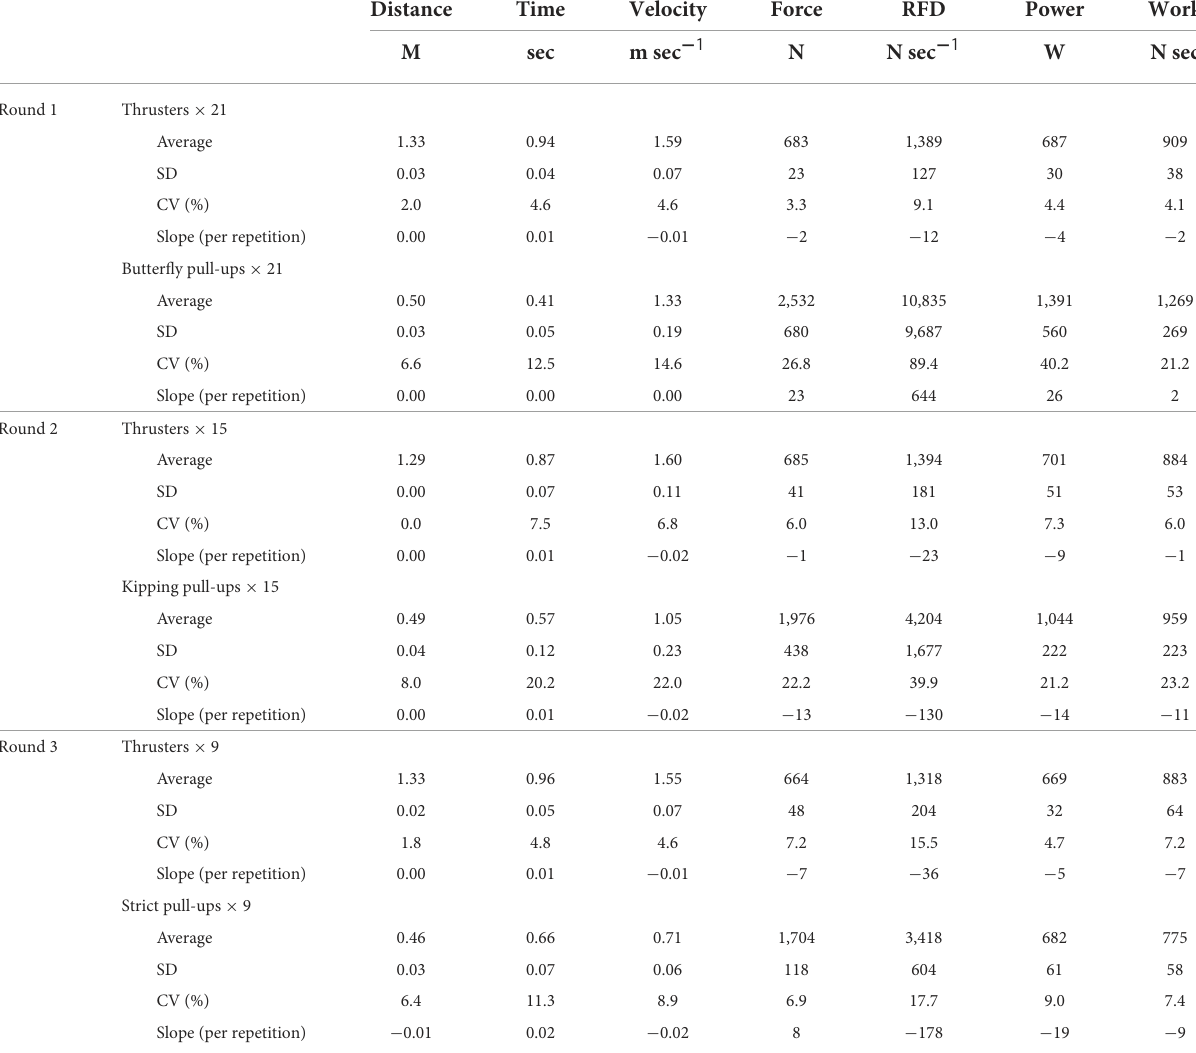
TABLE 5 Expressed kinetics during the benchmark workout “Fran.” Distance Time Velocity Force RFD Power